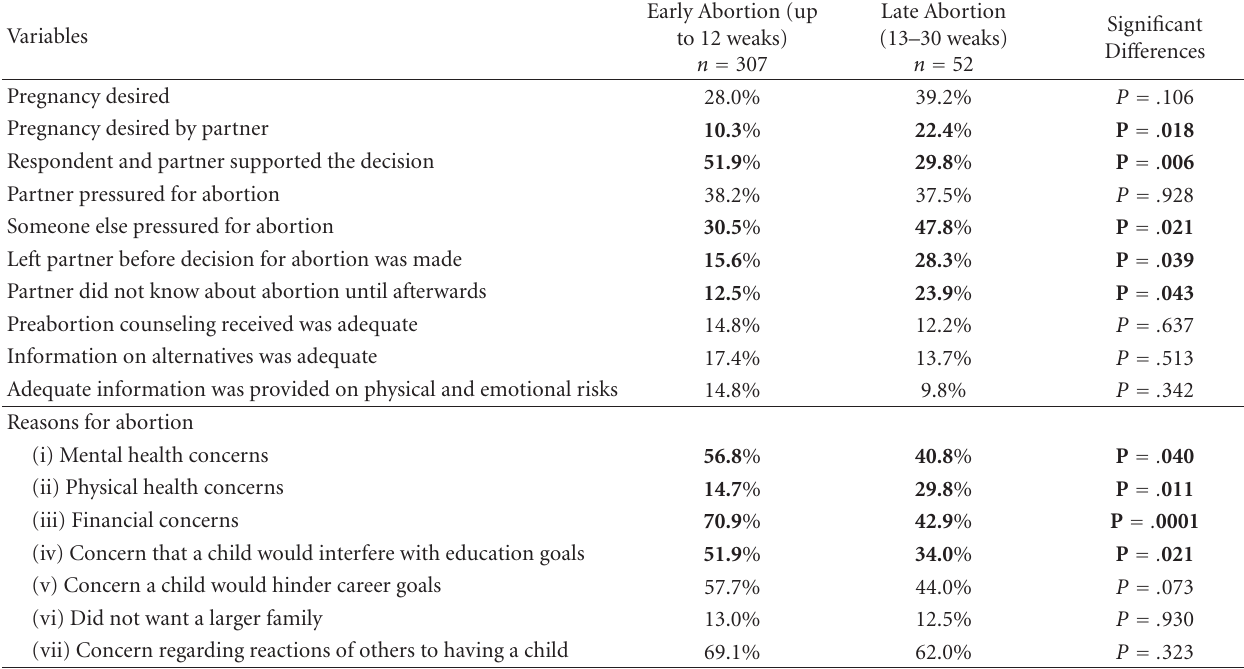
Table 2: Di ff erences in variables surrounding the abortion experience based on abortion